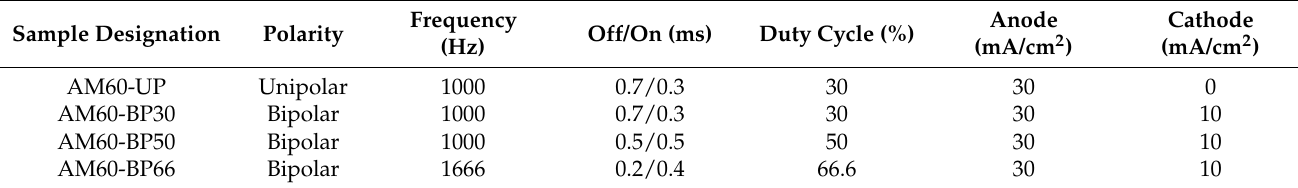
Table 1. The different applied parameters; frequencies and